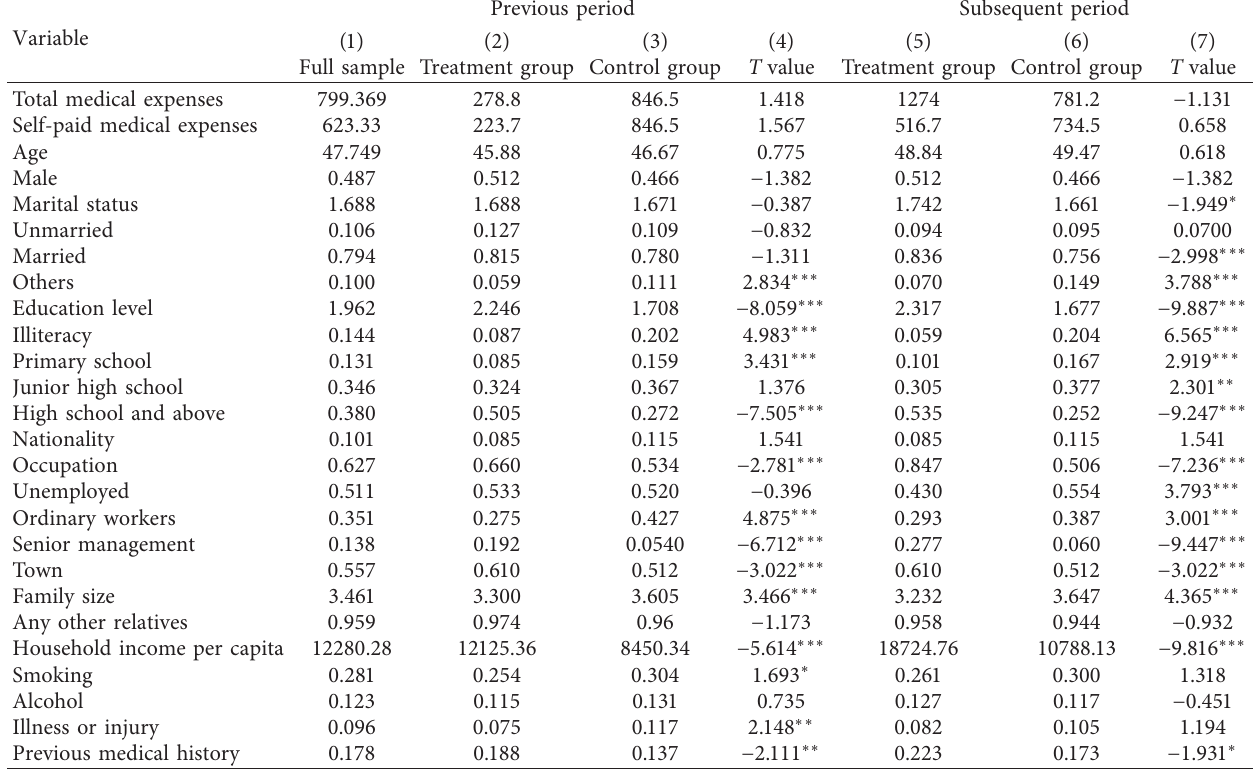
Table 2: Differences between treatment group and control group.